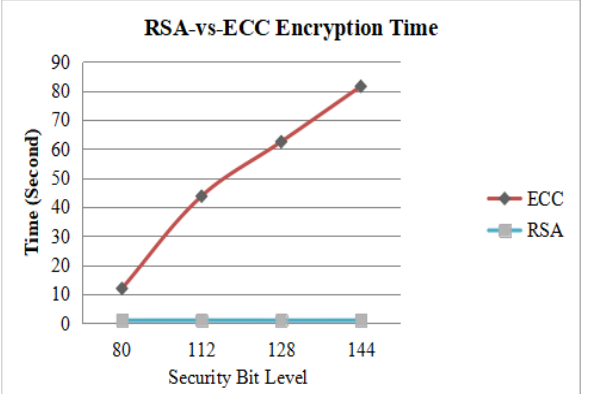
Figure 10. Total time (in sec.) of ECC and